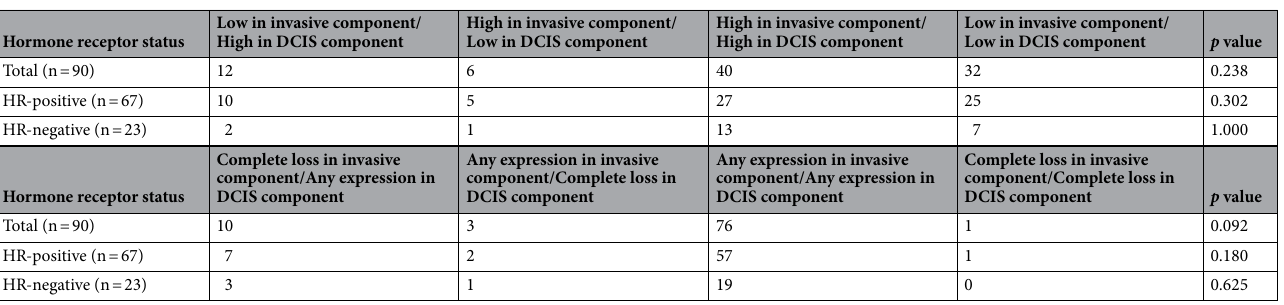
Table 2. Comparison of HLA class I expression in the DCIS and invasive components within same tumors. p values were calculated by McNemar test. HLA human leukocyte antigen, DCIS ductal carcinoma in